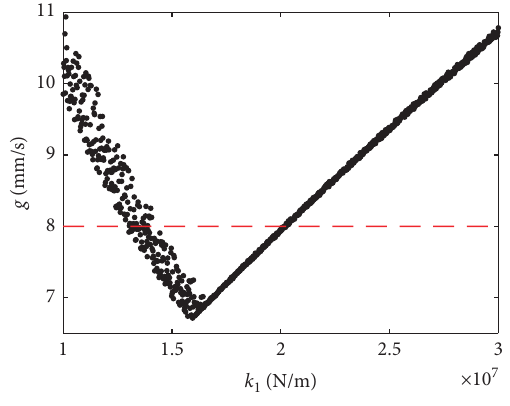
Figure 11: Main effect plot for k